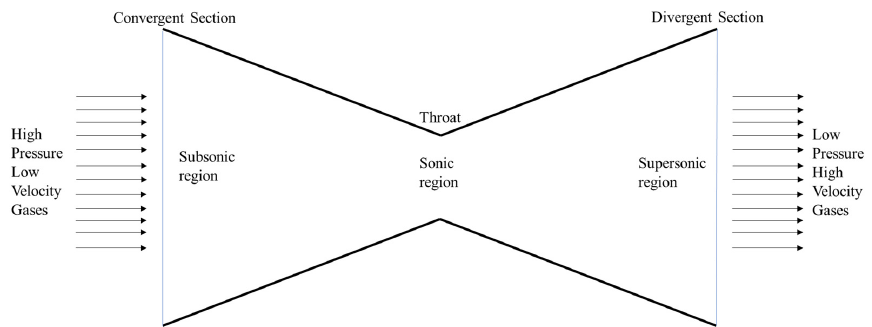
Figure 2. Convergent–divergent (CD) nozzle.